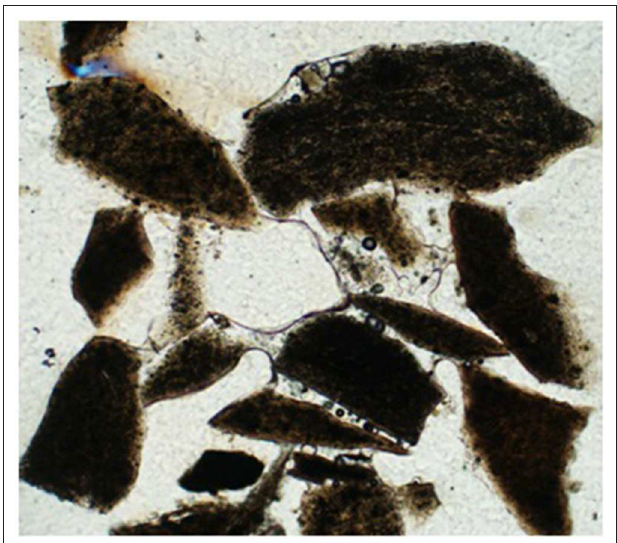
FIGURE 6 | Transmitted light microscope image of a cluster of mullite grains bonded together by a transparent adhesive made up mostly of potassium and silica. Sample is from an air gasification experiment collected at the base of reactor after a run duration of 8h. Length of image is 1,000 µ m.